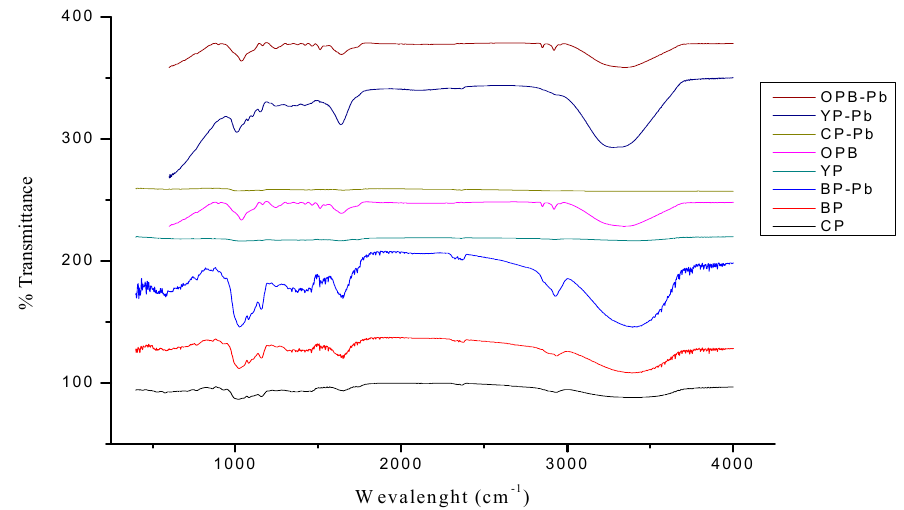
Figure 1. Spectrum from Fourier Transform Infrared Spectroscopy of biomasses before and after the Pb(II) adsorption process.